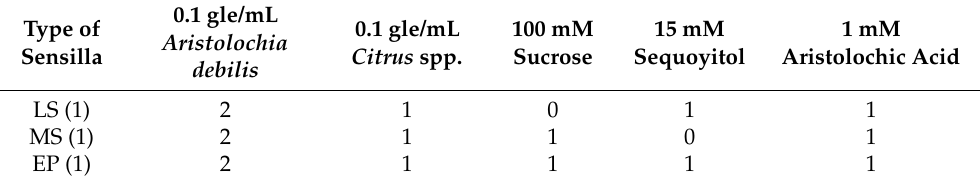
Table 2. Number of cells responding to various stimulants in Atrophaneura alcinous larvae. 0.1 gle/mL 0.1 gle/mL 100 mM 15 mM 1 mM Type of Aristolochia Citrus spp. Sucrose Sequoyitol Aristolochic Acid Sensilla debilis LS (1) 2 1 0 1 1 2 1